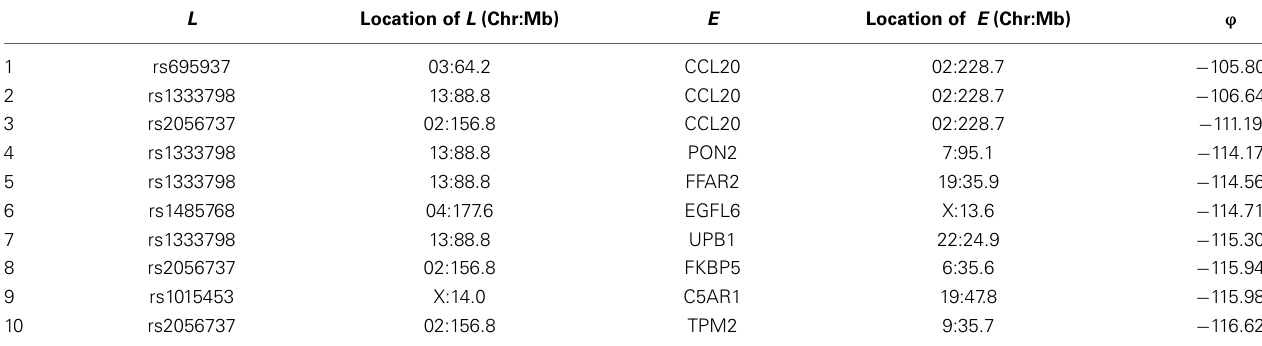
Table 2 | Top 10 scoring triplets for 5-FU, and associated ϕ